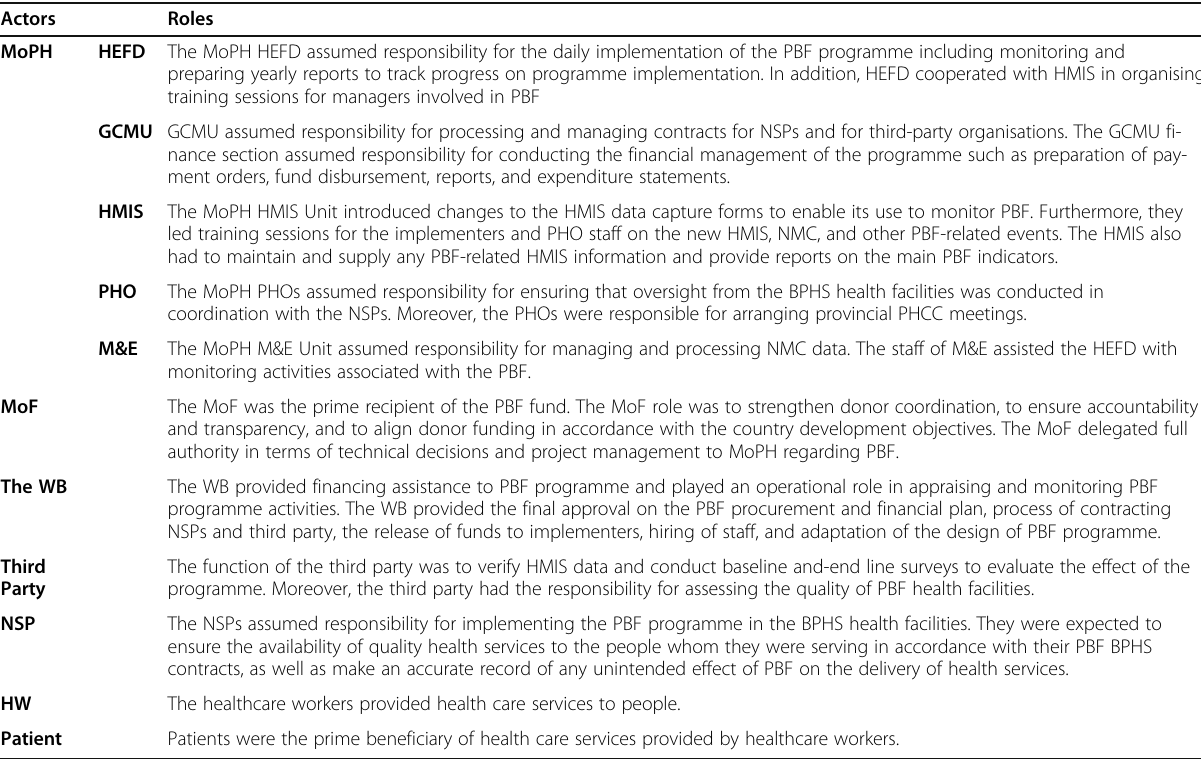
Table 2 PBF programme key actors ’ role Actors Roles